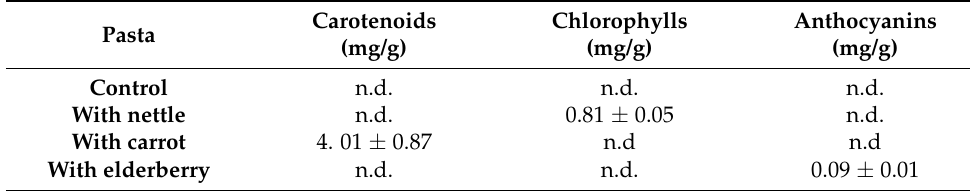
Figure 1. Sensory properties of evaluated types of pasta (sum of all panelists): CP, carrot powder; EP, elderberry powder; NP, nettle powder.